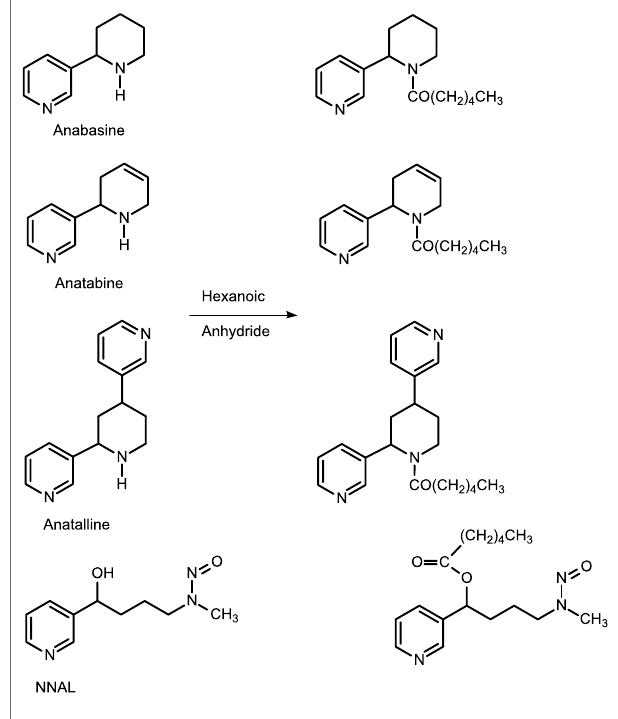
FIGURE 4 | Derivatization of alkaloids and NNAL with hexanoic anhydride prior to LC-MS/MS